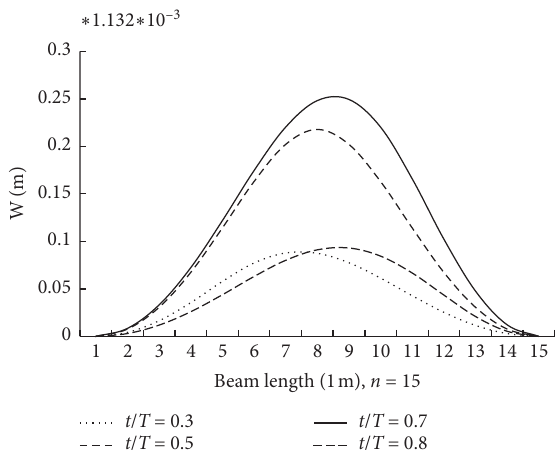
Figure 4: S-S EB Beam (3) deflection, F � 30N.